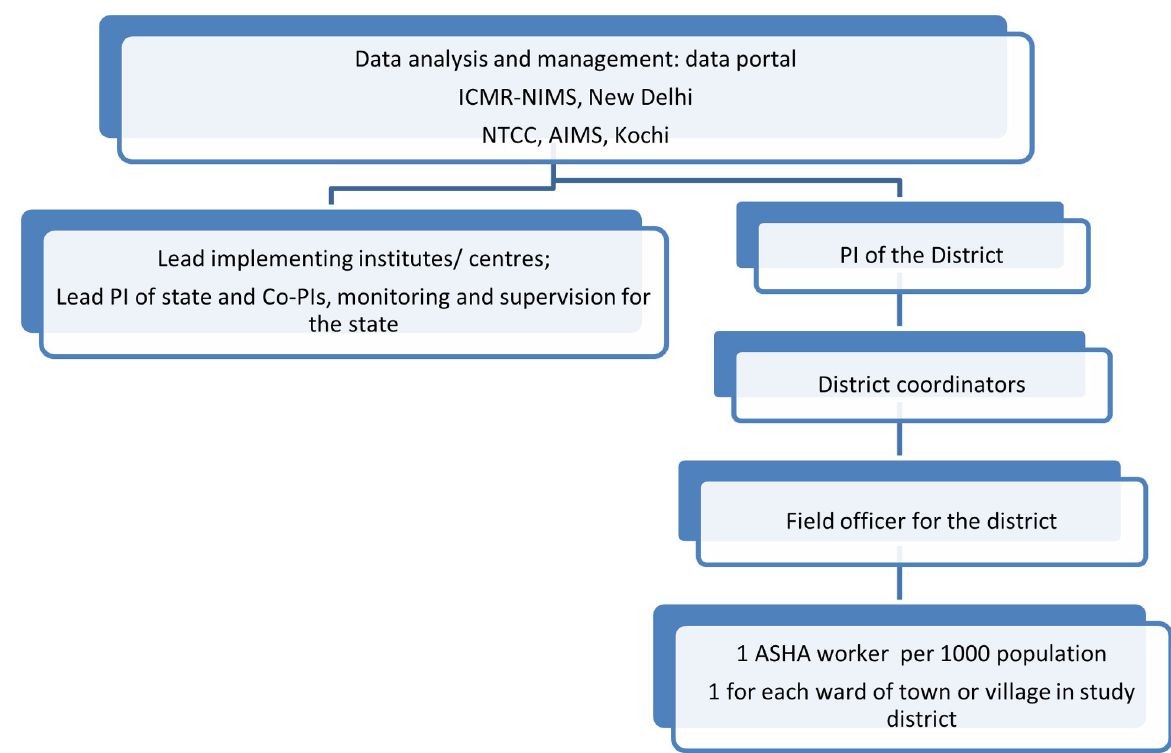
Fig 1. Flowchart of study management